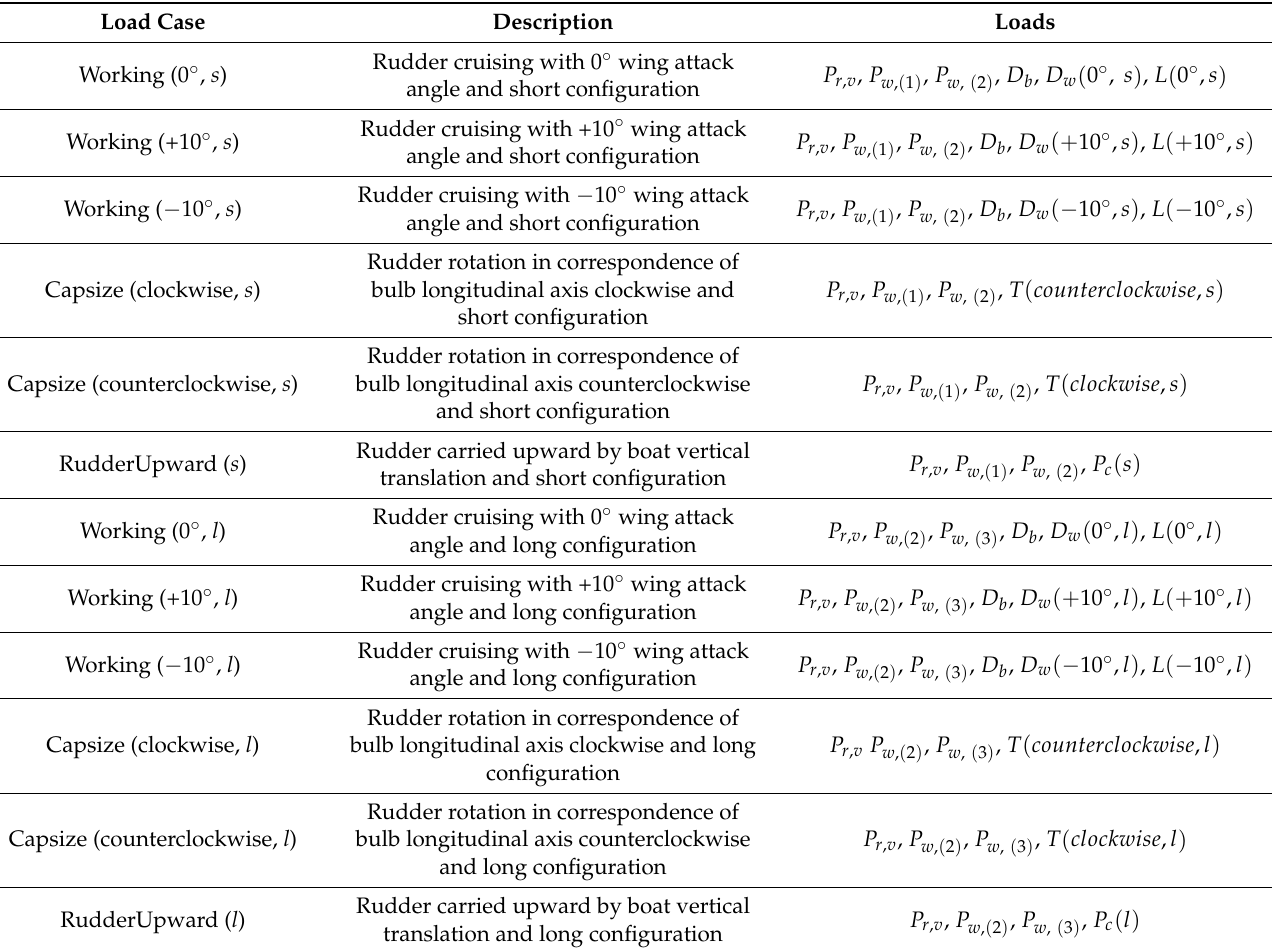
Table A2. Definitive load cases